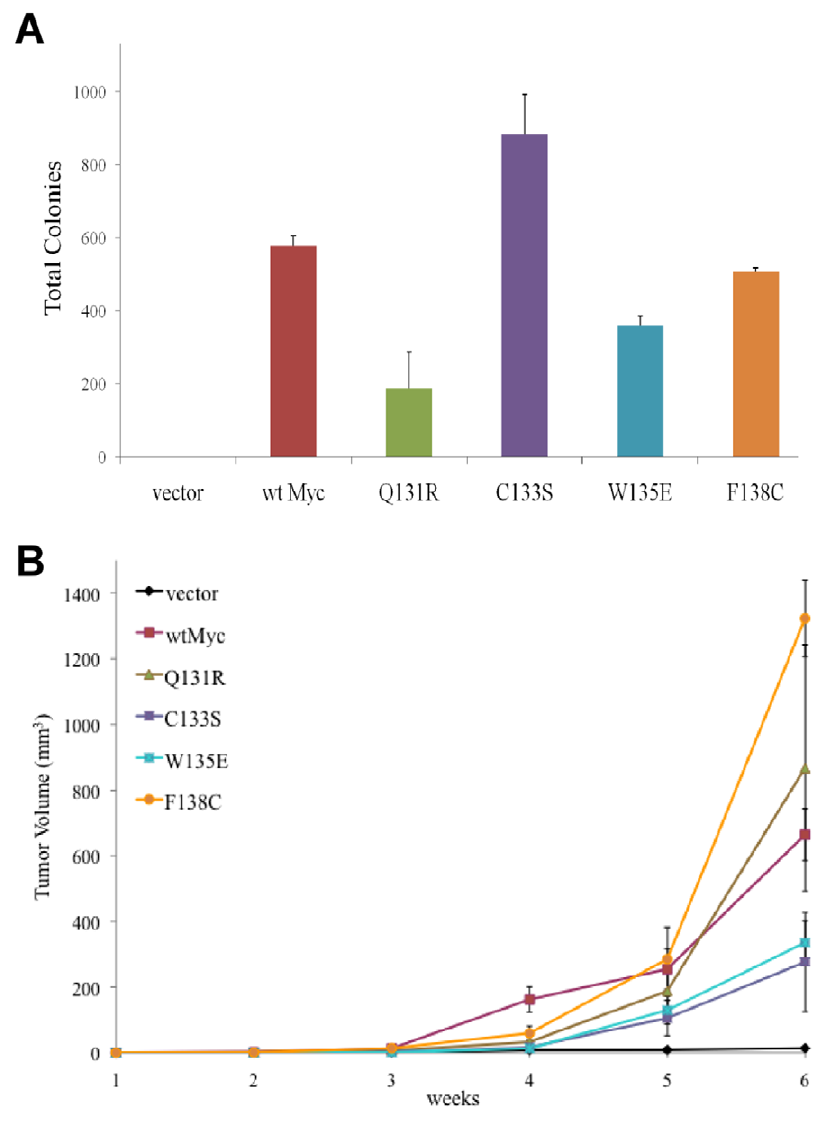
Figure 6. Effect of Myc point mutations on transformation. ( a ) In vitro transformation. Anchorage-independent clonogenic growth in soft agar was assessed as previously described [54,56]. 12–14 days after plating, the total number of macroscopically visible colonies on each plate was quantified. Numbers shown represent the average number of colonies seen in triplicate cultures + / 2 1 SE. p-values of the comparisons with vector control cells were calculated by a two-tailed t-test in Microsoft Excel: (**) p # 0.01; (***) # 0.005. ( b ) In vivo transformation. 5 6 10 6 of the indicated Rat1a cell lines were inoculated subcutaneously into the flanks of nude mice. Each inoculum was performed in triplicate and tumor sizes were evaluated weekly. The data shown represents two individually repeated experiments. Averages tumor sizes [52] + / 2 1 SE are depicted as a function of time.